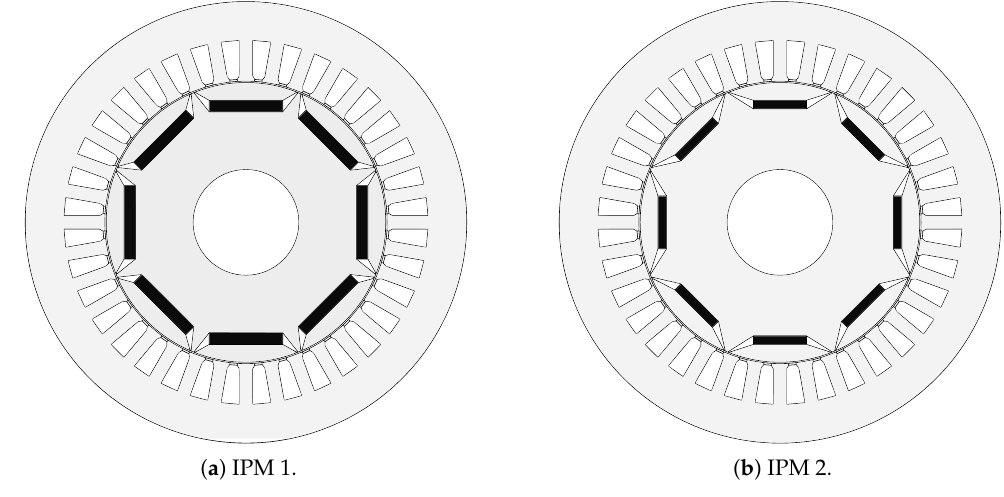
Figure 22. Traditional IPM motors.